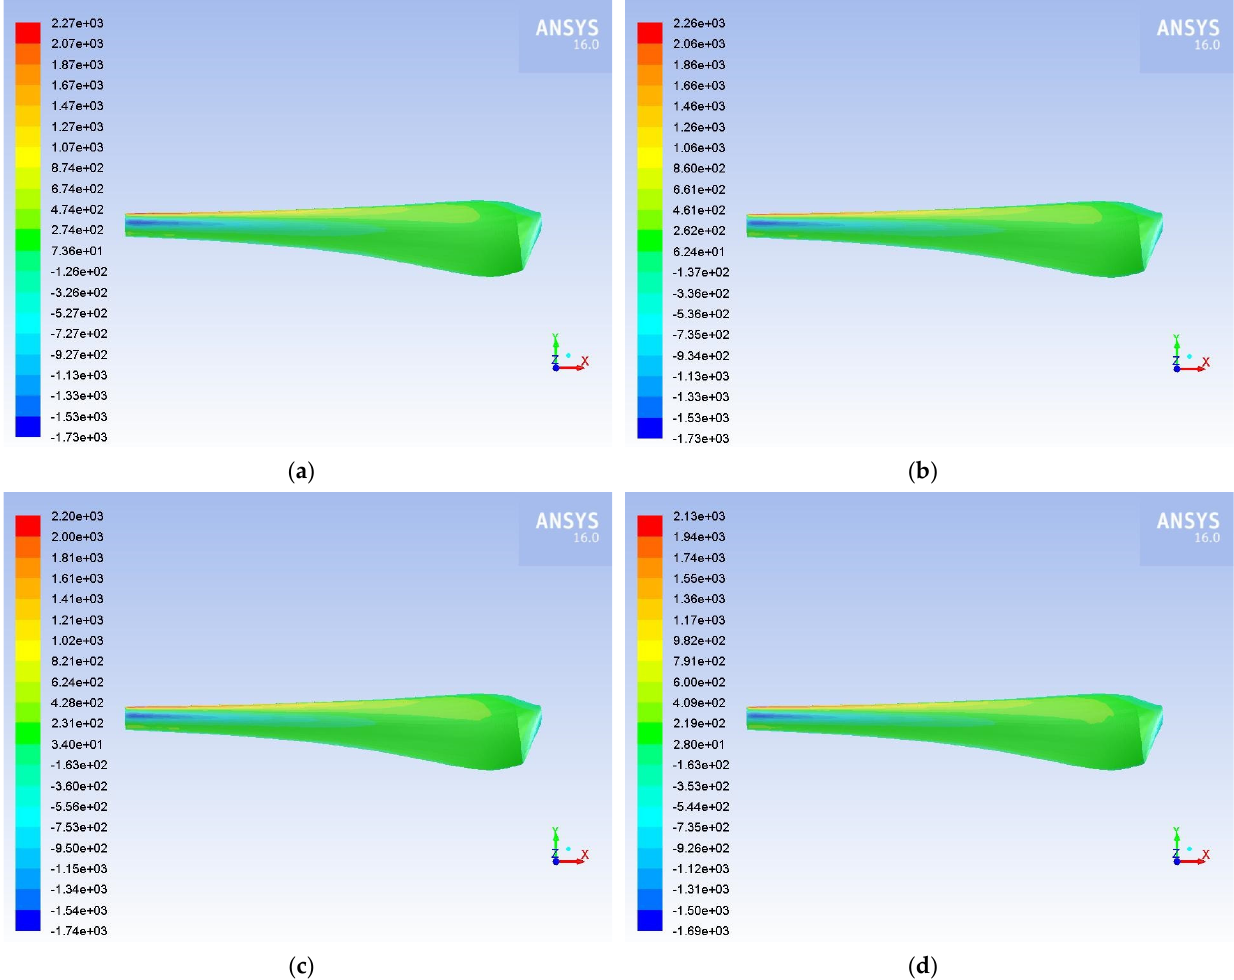
Figure 7. Static pressure contours at the blade’s pressure side and at wind speed of 10 m·s − 1 . ( a ) Q